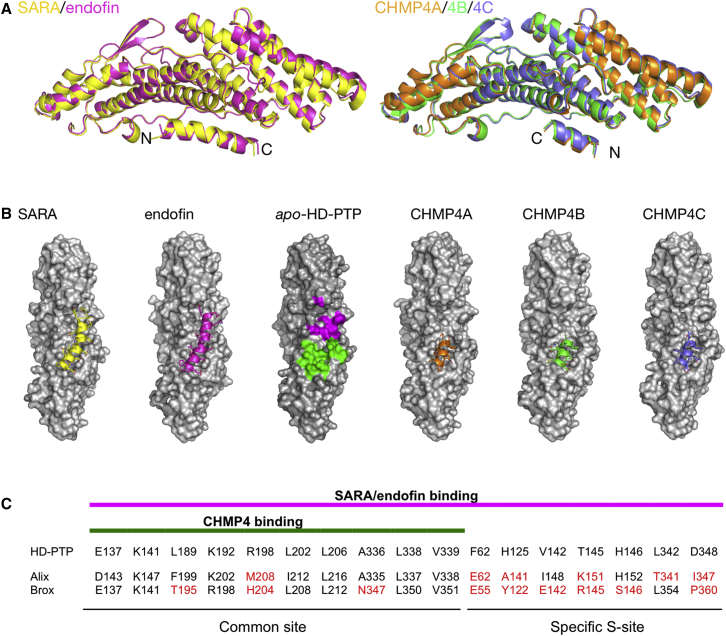
Crystallographic Structures of HD-PTPBro1 with Endosomal Effectors(A) Ribbon diagrams showing the structures of the complexes of HD-PTPBro1 with SARA (yellow) and endofin (fuschia) peptides on the left, and with the three CHMP4 isoform peptides (4A, orange; 4B, green; 4C, purple) on the right. All peptides form helical structures and bind to the concave region of the Bro1 domain.(B) Surface representations of the six structures determined in this study, showing the peptides as α-helical ribbons and the Bro1 domains as molecular surfaces (gray). The colored regions in the apo-HD-PTP structure highlight the common-CHMP4 binding site (green) and the specific S site (magenta), only utilized by the SARA/endofin peptides. Peptides are color coded as in (A).(C) Residues in the Bro1 domain involved in binding to the effector peptides at the common and specific sites in the structures shown in (B). Conserved residues between Bro1 proteins are shown in black and substitutions are in red. The different binding sites are labeled (common site and S site) and the extent of the interface between CHMP4 peptides (green) and SARA/endofin (fuschia) is highlighted.